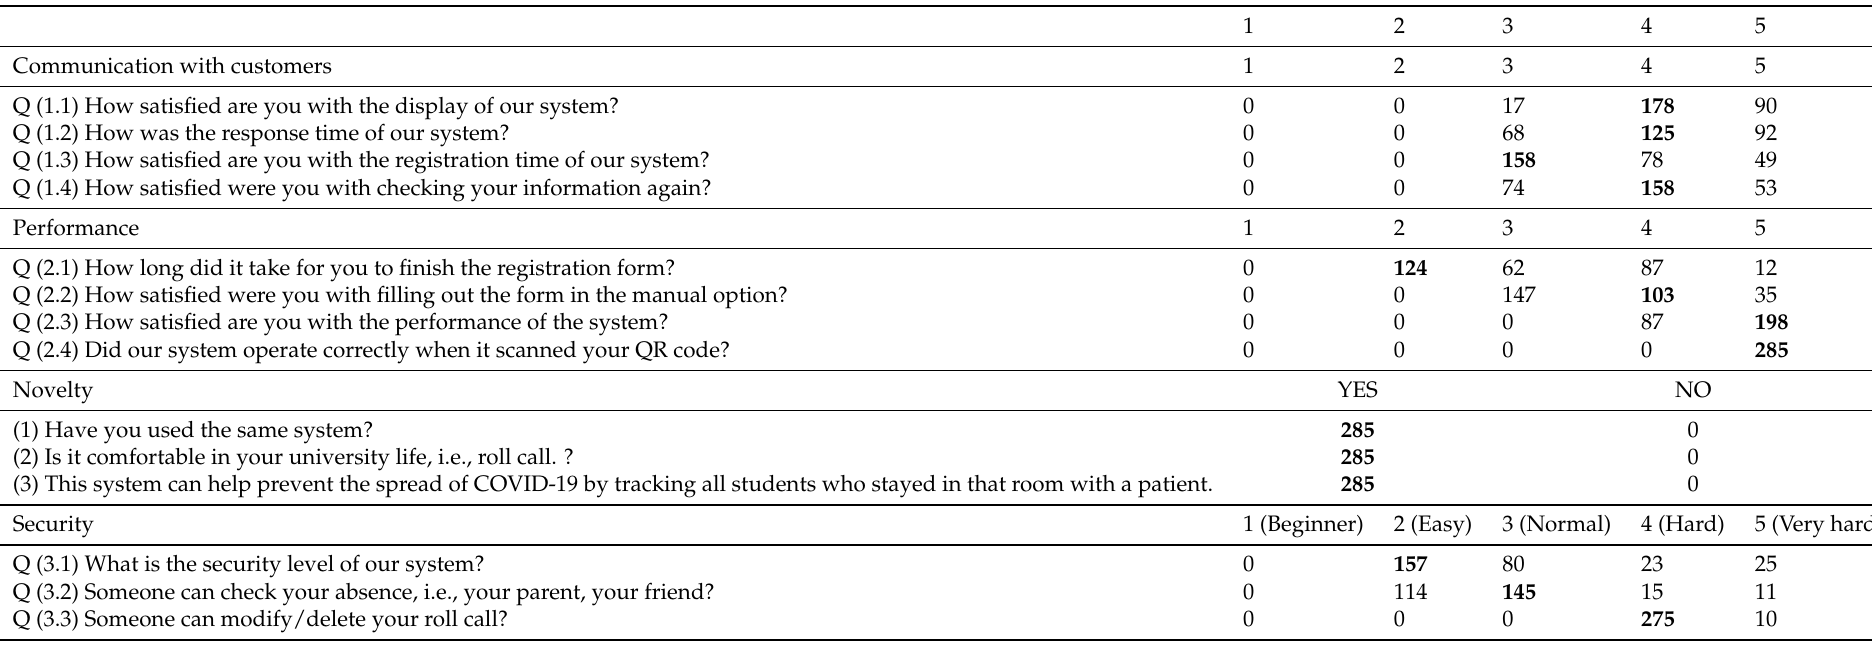
Table 3. Summary of survey